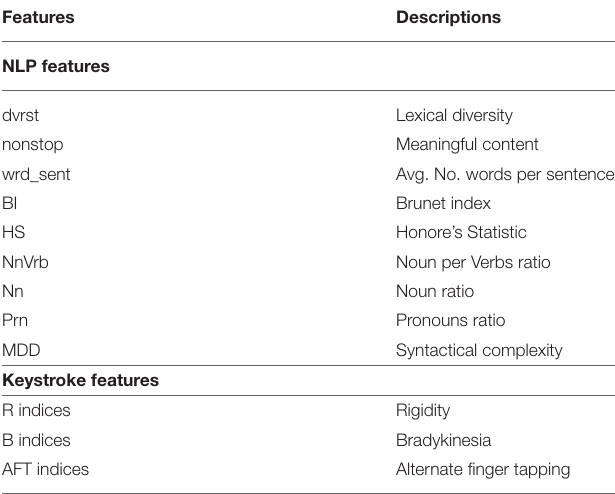
TABLE 3 | Features from the natural language and typing